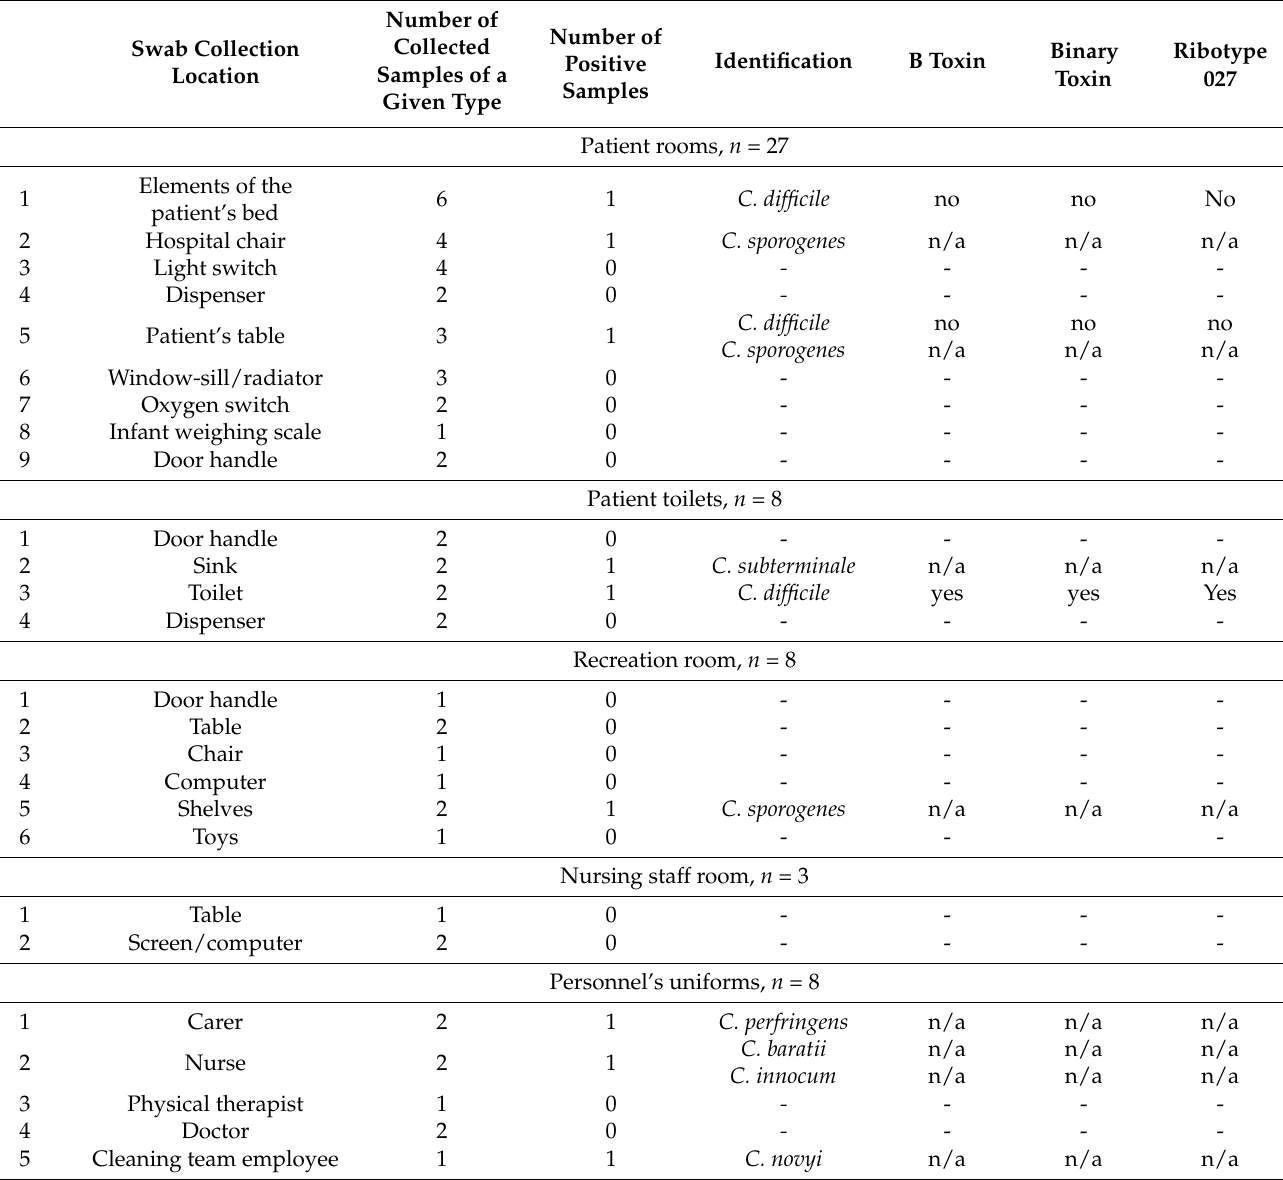
Table 2. Results of the micro biological testing conducted at the Gastroenterology Unit ( n = 54 total